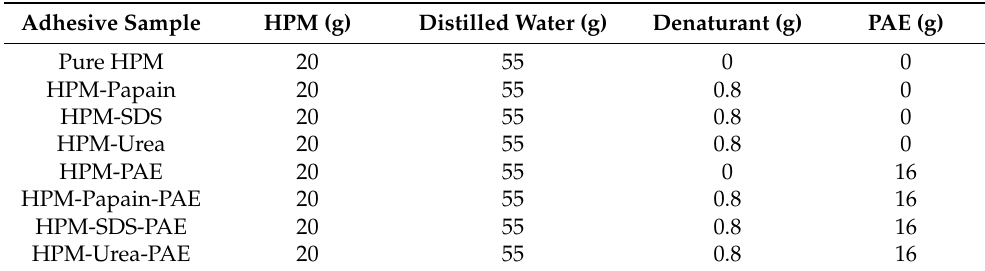
Table 1. Formulations used for adhesive